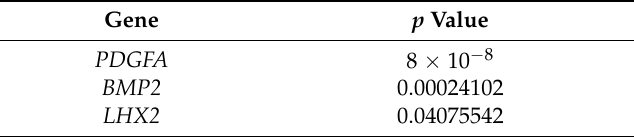
Table 3. Analysis of variance (ANOVA).